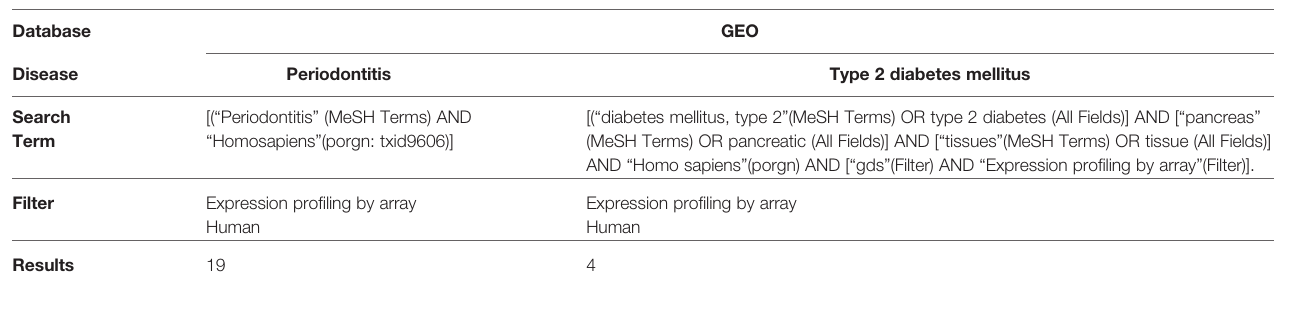
TABLE 1 | Electric search strategy in